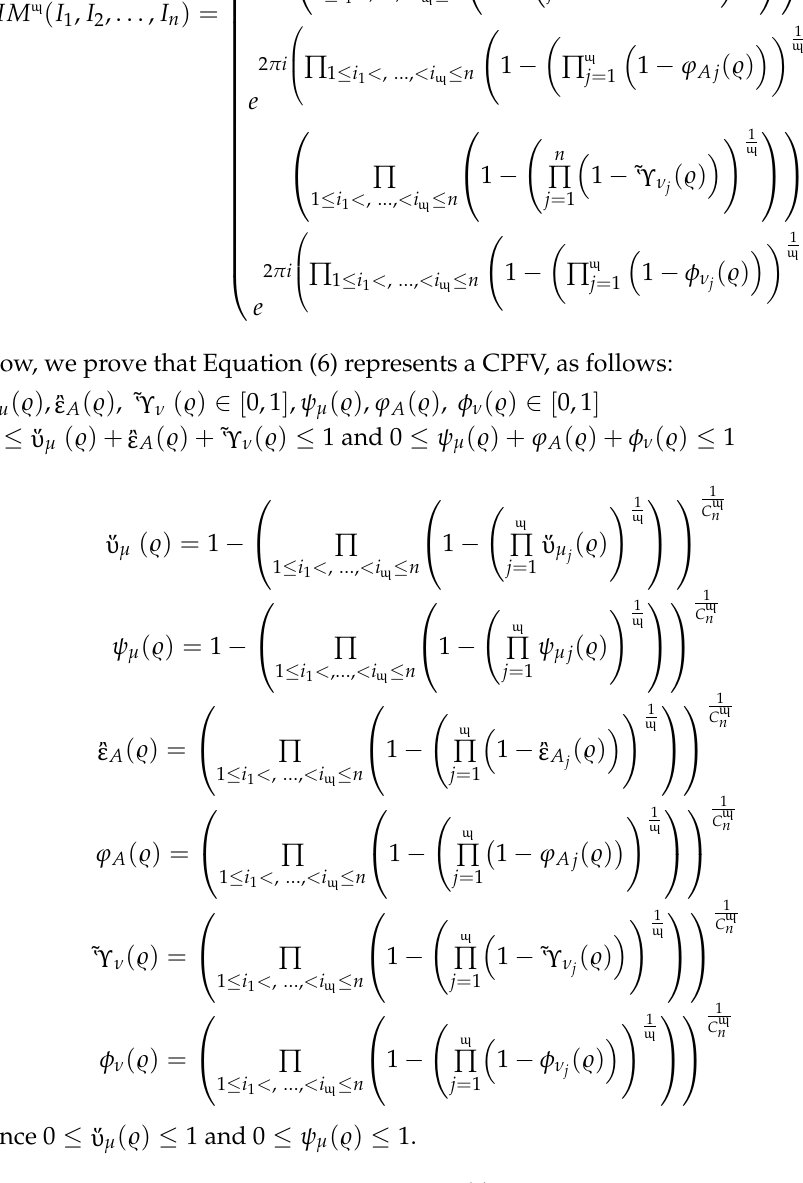
Table 1. Symbols and their meanings.